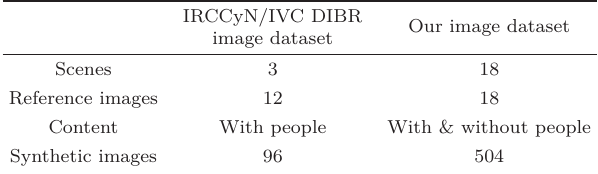
Table 1 Details of our proposed DIBR synthetic image